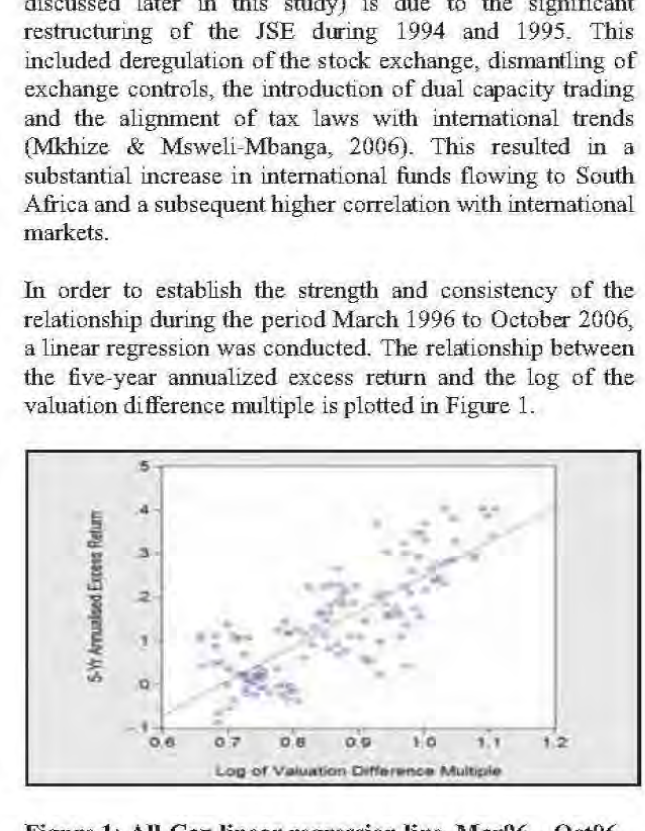
Figure 1: All-Cap linear regression line, Mar96- Oct06 The upward sloping trend line in Figure 1 indicates a strong positive relationship between the ftve-year annualized excess return and the log of the valuation difference multiple. Special mention should be made of the high positive correlation coefficient of 0,80 between the variables.